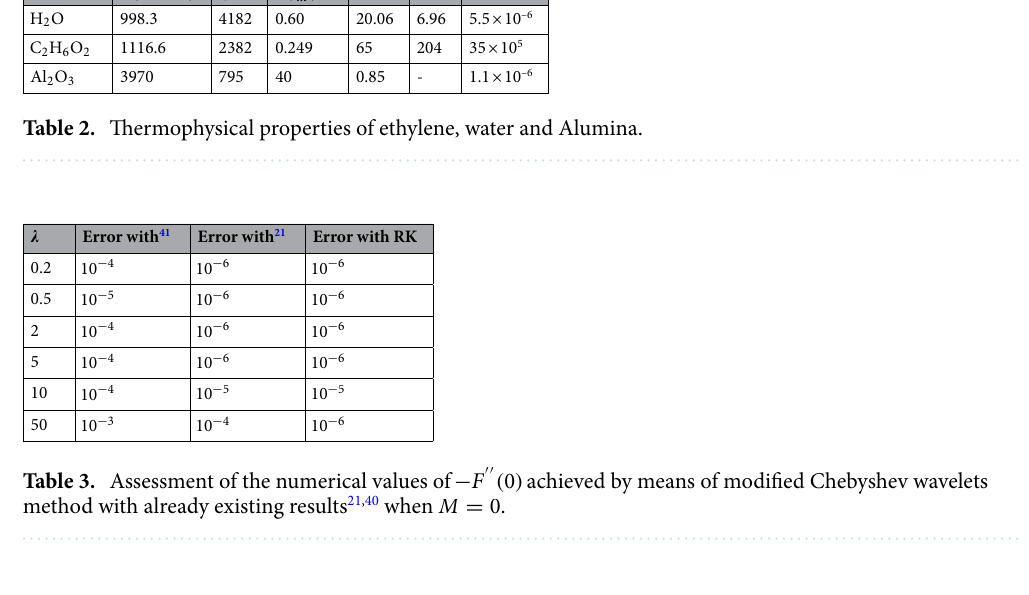
Fig. 3. The observations display that the velocity of nano-fluid is decreasing gradually between 0 C 2 H 6 O 2 has higher velocity as compared γ Al 2 O 3 γ Al 2 O 3 − become thinner with increasing values of (cid:31) which promote the decreasing behavior of velocity of nano-fluid. However, it just can be observed between 0 values of (cid:31) . On the other hand the velocity of the system is monotonically declining for lesser values of (cid:31) and this approach become non-monotonic for (cid:31) latory motion of the fluid close to the wall is acted and for (cid:31)